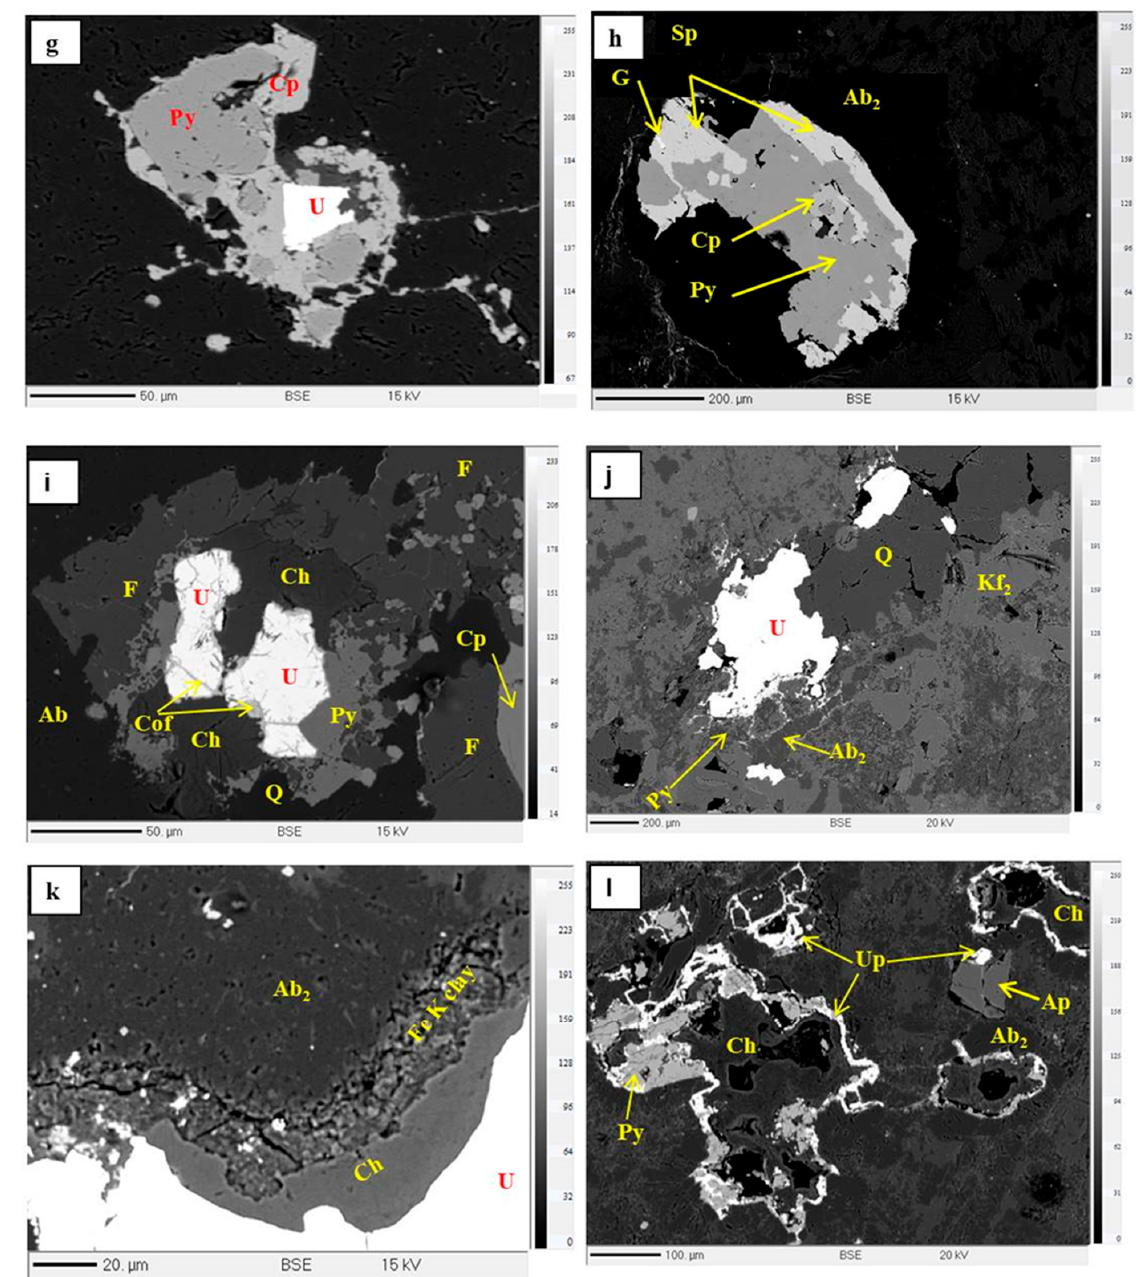
Figure 10. BSE images. ( a ) Molybdenite (Mo) strands parallel to the fracture (do tt ed line) and albite (Ab 2 , dark grey), replacing K-felspar (Kf 1, light grey) along the fracture showing sawtooth-shaped intergrowths; ( b ) the development of fl exural slip folds on molybdenite strands due to D 2 defor- mation; ( c ) the oxidation of fractured pyrite (Py) to goethite (Goe) and the alteration of folded mo- lybdenite (Mo), the altered portions of molybdenite marked as Mo(A) show a much lower brightness than the unaltered part; ( d ) elemental X-ray images of Mo-L α and Si-K α on the demarcated portion in fi gure ( c ) indicate variations in elemental concentrations of Mo within the molybdenite grains due to partial alteration by Si bearing fl uid; ( e ) U-mineralisation along the fractured contact of the QFBS ( top left ) and quar tz ite ( bo tt om right ); note formation of secondary K-felspar (Kf 2 ) and albite (Ab 2 ) surrounding uraninite (U) grains; Ab 2 was also observed to replace Kf 1 of the QFBS; ( f ) pyrite stringers along the microfractures developed parallel to the long axis of actinolite (Act) during D 2 deformation, the formation of sphalerite (Sp) and sphene (Spe) towards the close of D 2 deformation,